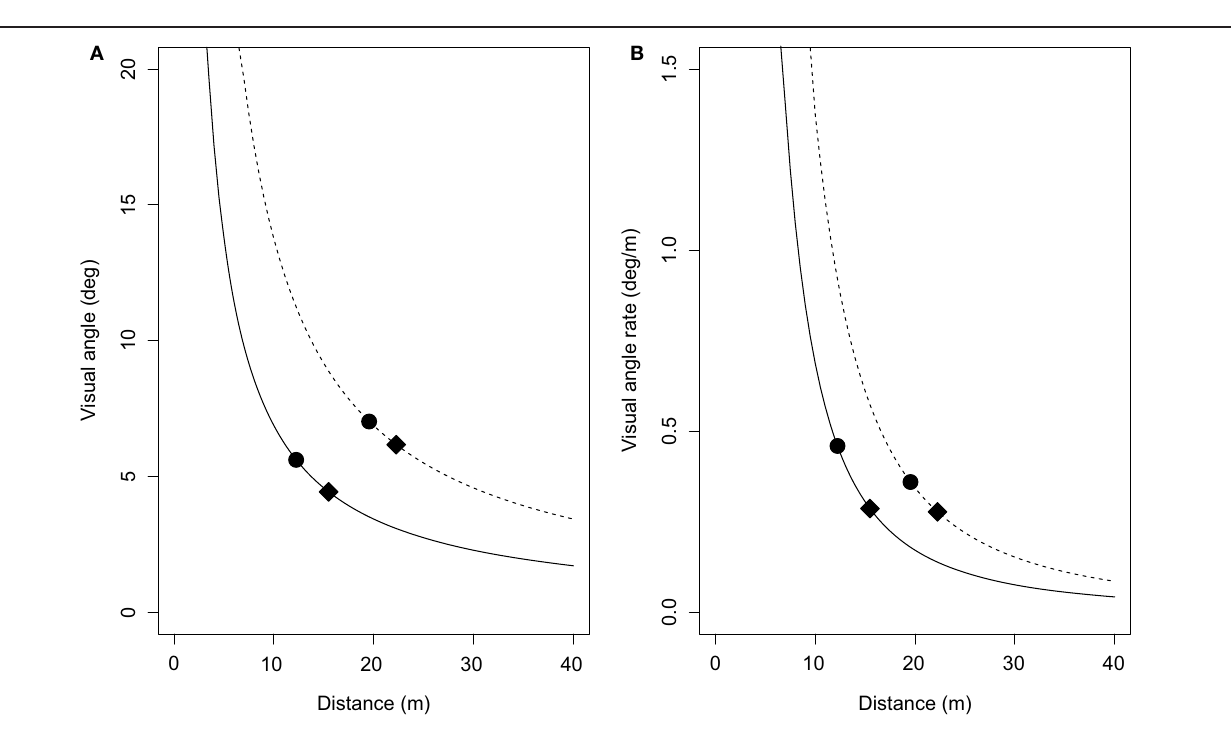
from the viewpoint. Mean visual angles (and visual angle rates) of the smaller and larger objects are shown for the velocity-control condition (filled circles) and acceleration-control condition (filled diamonds). See text for